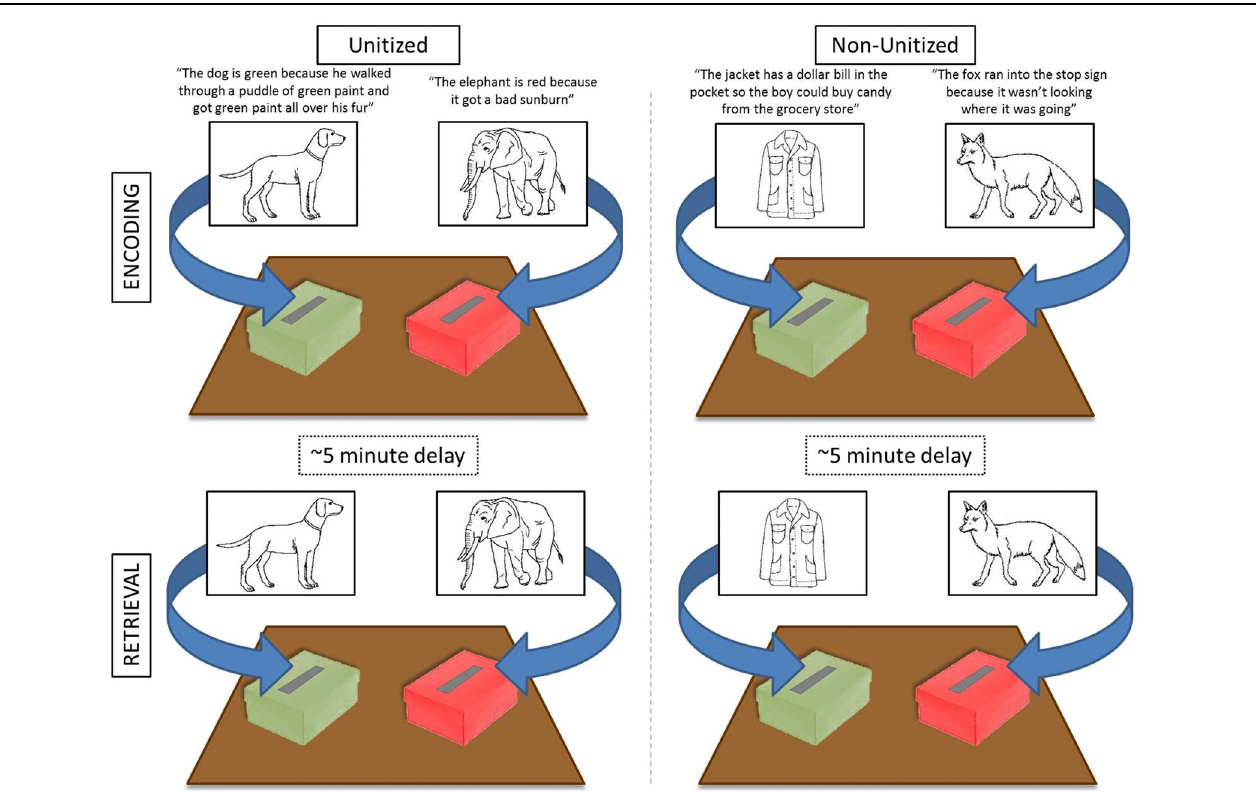
FIGURE 1 | Schematic of experimental design. Two colored boxes were placed on the table in front of the child. During each encoding block (i.e., Unitized or Non-Unitized; top panels) children were presented with 30 stimuli, one at a time, and instructed to place the card into the appropriate box based on the story. At retrieval, the same images were randomly presented without the